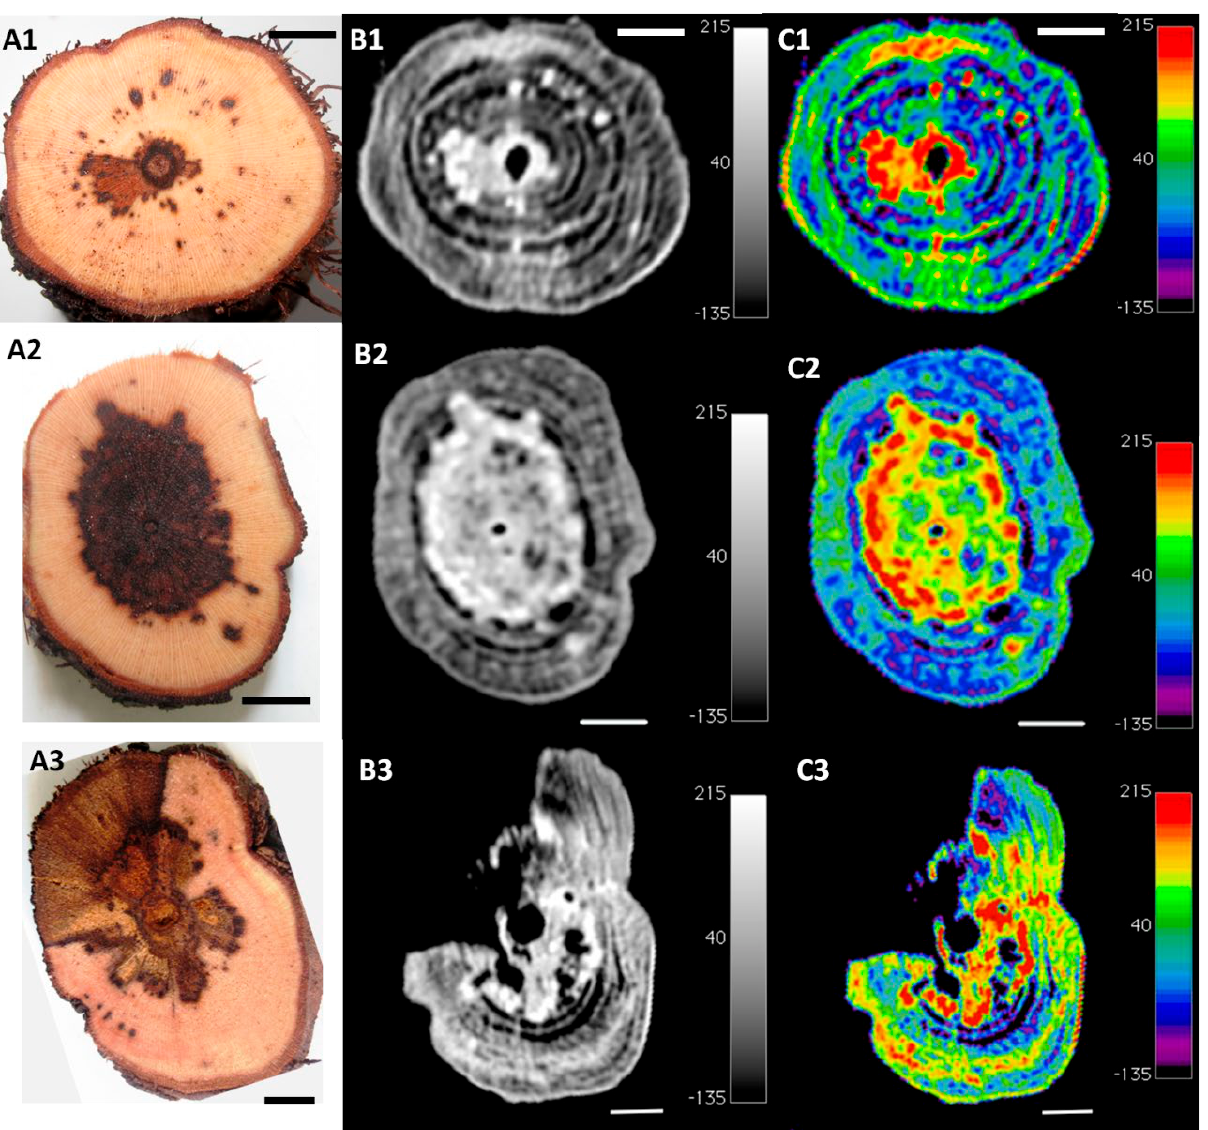
Figure 3. Original photographs (A) and computed tomography scan images (B and C) showing a symptomatic grapevine trunk (cv. Touriga Nacional) at (1) early, and (2) advanced stages of infection, and (3) white rot stage. (B) Tomographic analysis (grey colours; and (C) tomo- graphic analysis (UCLA colours), according to the radiodensity scales presented on the right side of B and C. Scale bars = 1 cm. CT scan images extracted from Osirix v.